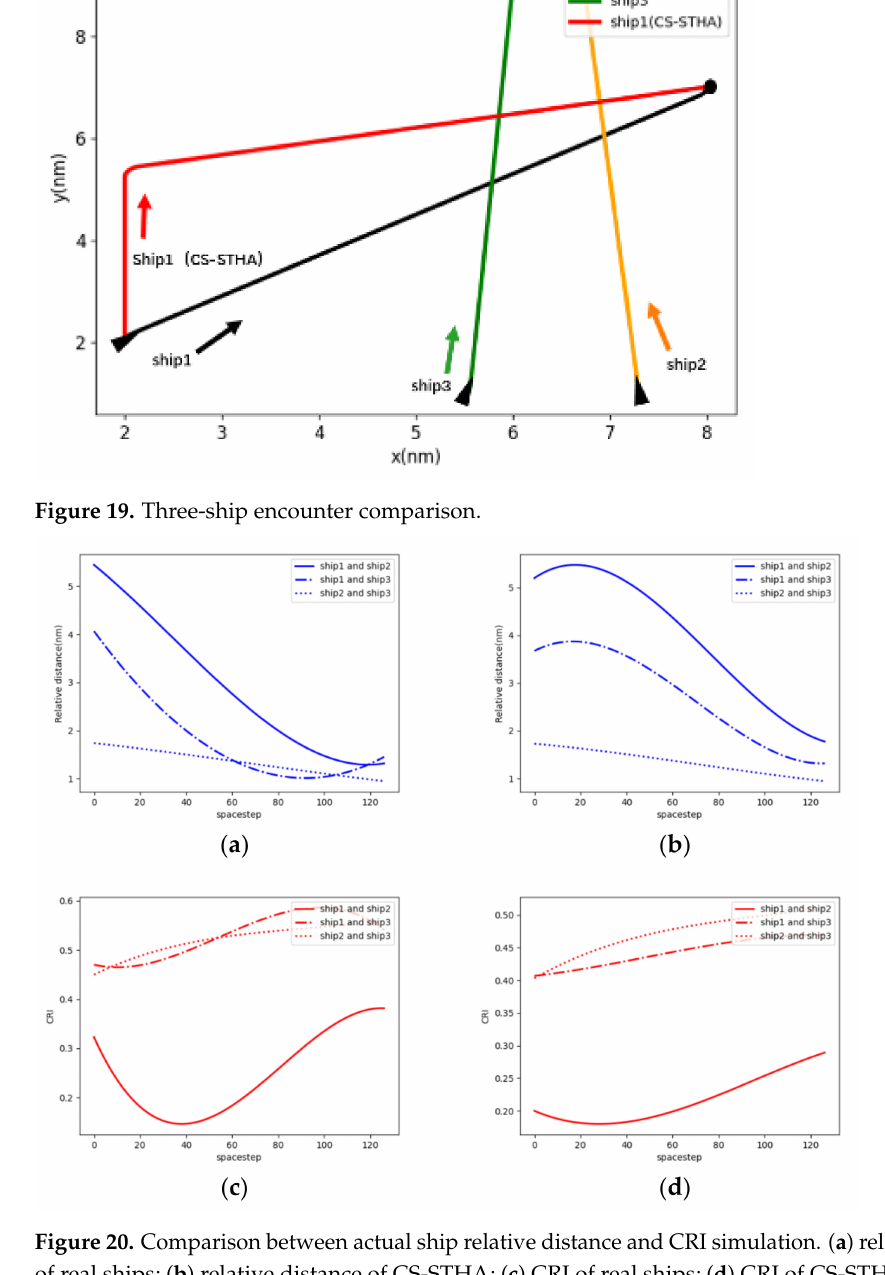
Figure 20. Comparison between actual ship relative distance and CRI simulation. ( a ) relative distance of real ships; ( b ) relative distance of CS-STHA; ( c ) CRI of real ships; ( d ) CRI of